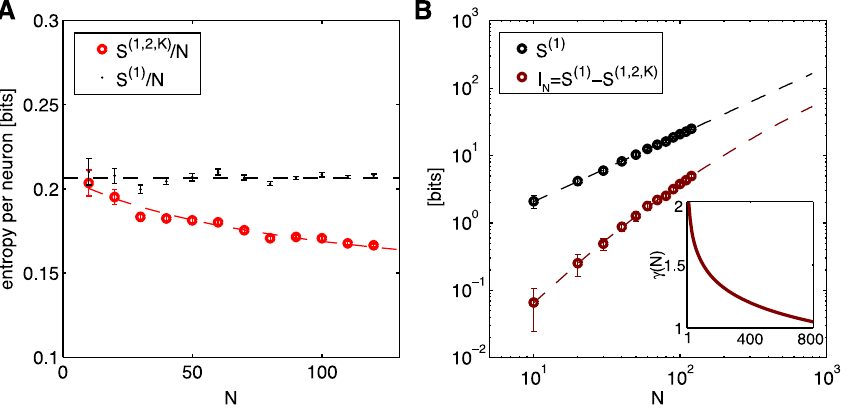
Figure 13. Entropy and multi-information from the K-pairwise model. ( A ) Independent entropy per neuron, S (1) = N , in black, and the entropy of the K-pairwise models per neuron, S (1,2, K ) = N , in red, as a function of N . Dashed lines are fits from (B). ( B ) Independent entropy scales linearly with N (black dashed line). Multi-information I N of the K-pairwise models is shown in dark red. Dashed red line is a best quadratic fit for dependence of log I N on log N ; this can be rewritten as I N ! N c ( N ) , where c ( N ) (shown in inset) is the effective scaling of multi-information with system size N . In both panels, error bars are s.d. over 30 subnetworks at each size N .